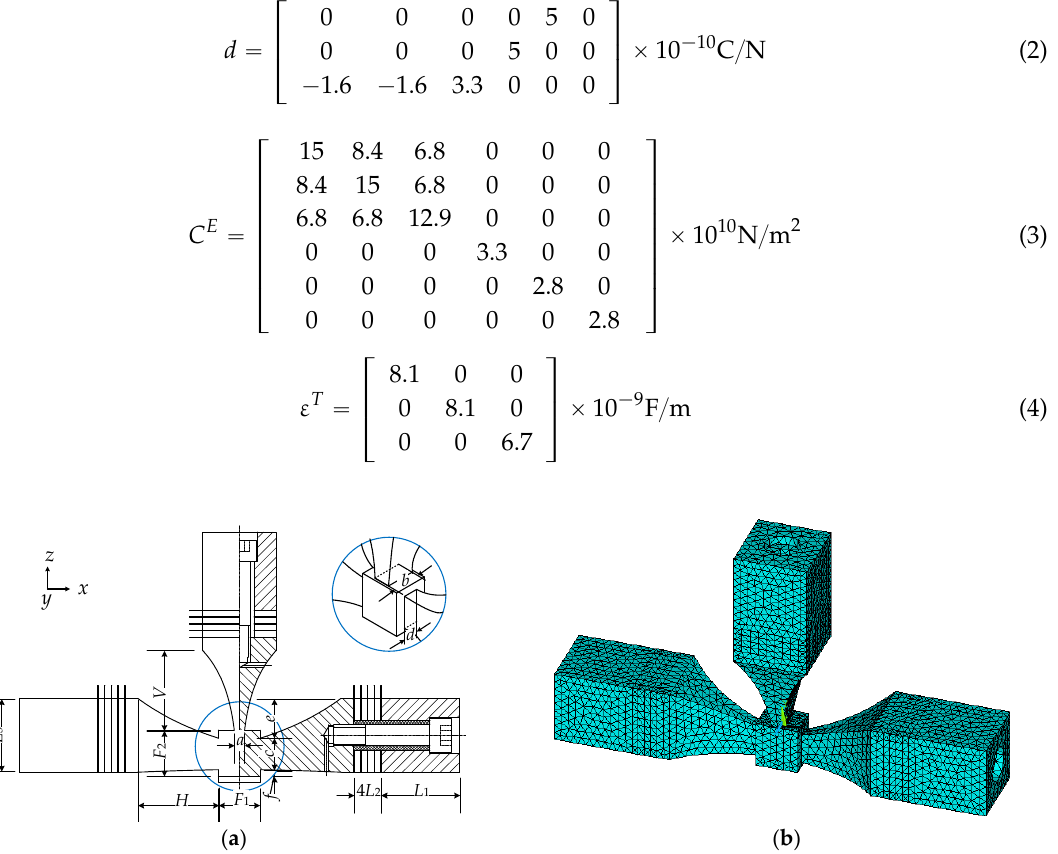
Figure 4. The section view and finite element model of the stator: ( a ) The section view and the main parameters of the stator; ( b ) Finite element model of the stator. Table 2. Initial values of the stator’s main parameters (mm).